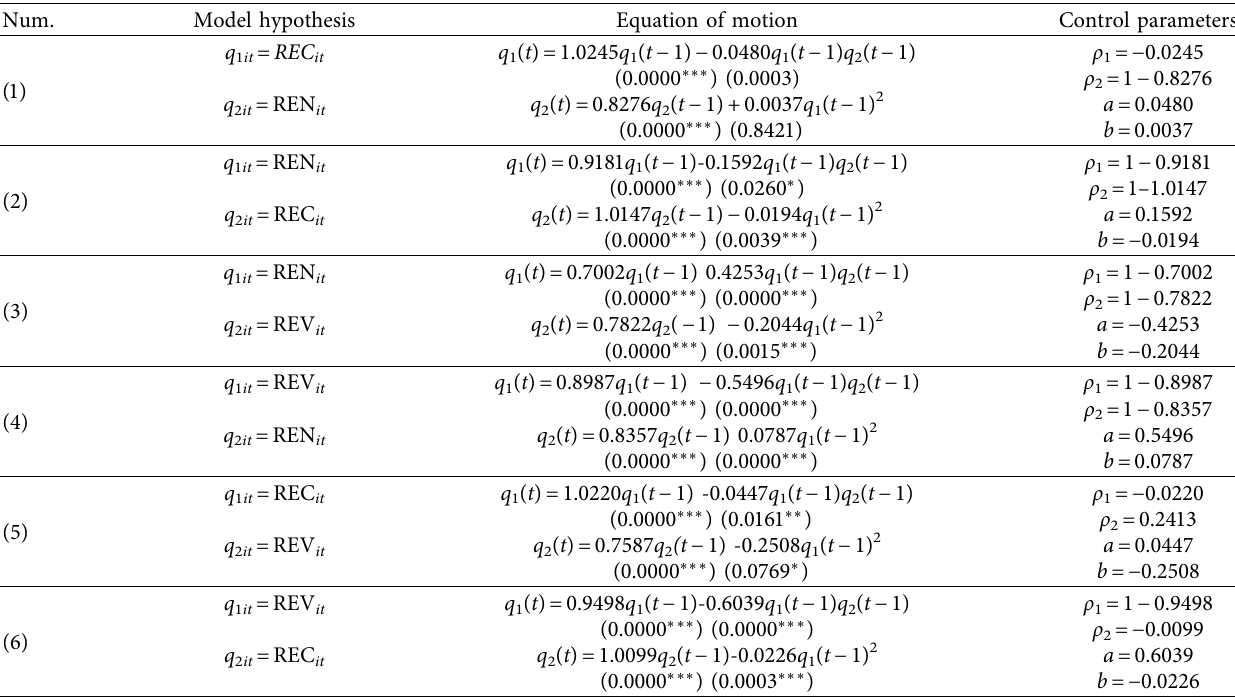
Table 4: Analysis results of system order parameter identification. Num.